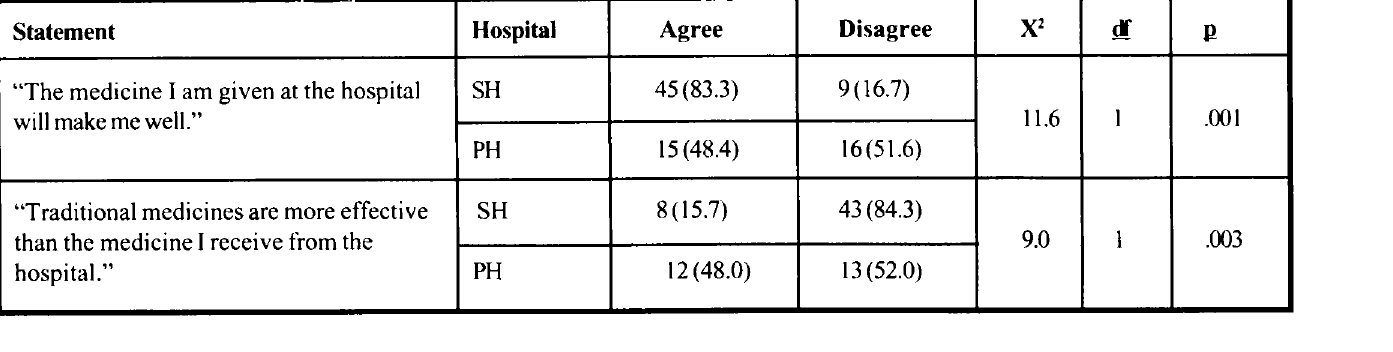
Table 4: TB hospital patients’ views of the necessity of their hospitalisation